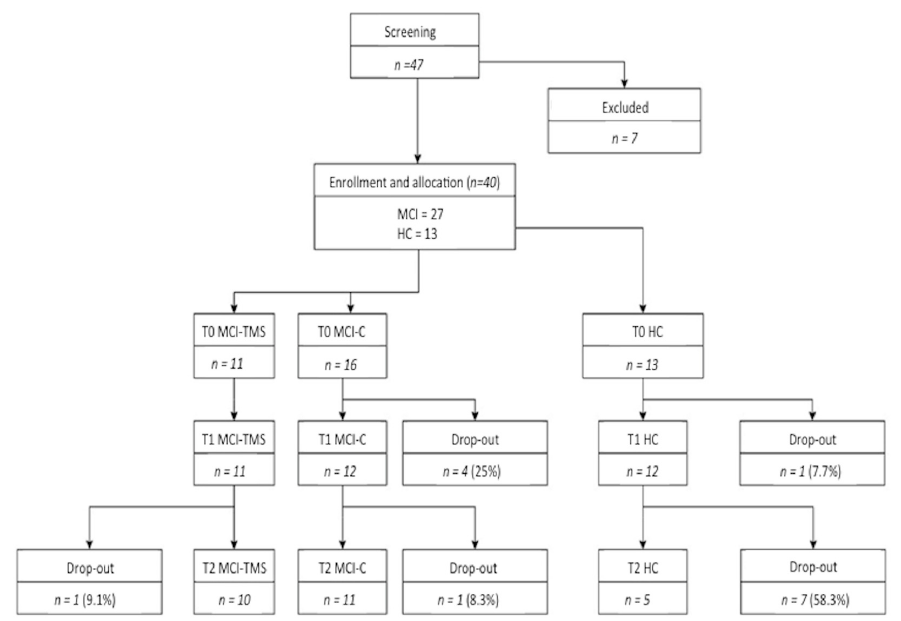
Figure 1. Flow diagram of referred and enrolled patients. Table 1. Between-group comparison on demographics and neuropsychiatric screening measures at pre-treatment evaluation; data are reported as median (25th, 75th percentile) or count